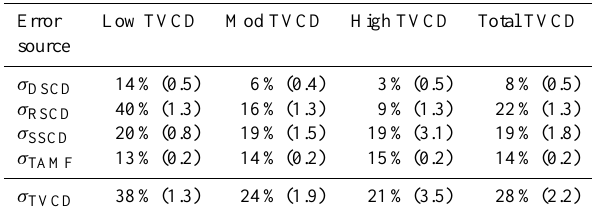
Table 2. Error budget on the retrieved tropospheric NO 2 VCDs. The typical relative and absolute errors (in percent and 10 15 moleccm − 2 respectively) are given for low (below 33th per- centile or <0.6 × 10 16 moleccm − 2 ) , moderate (between 33th and 66th percentile or 0.6 and 1.0 × 10 16 moleccm − 2 ) and high (above respectively. The last column gives the typical uncertainties on all retrieved